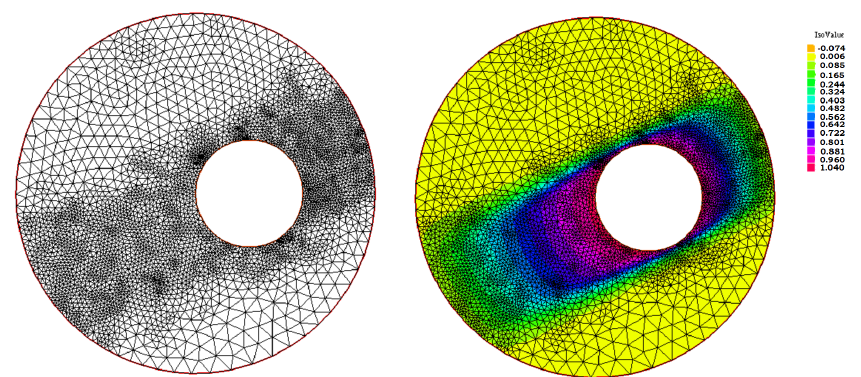
Figure 15. Results for example 3 with η R . ( Left ) The final adapted mesh. ( Right ) The final adapted mesh with the projected isolines of the computed solution.